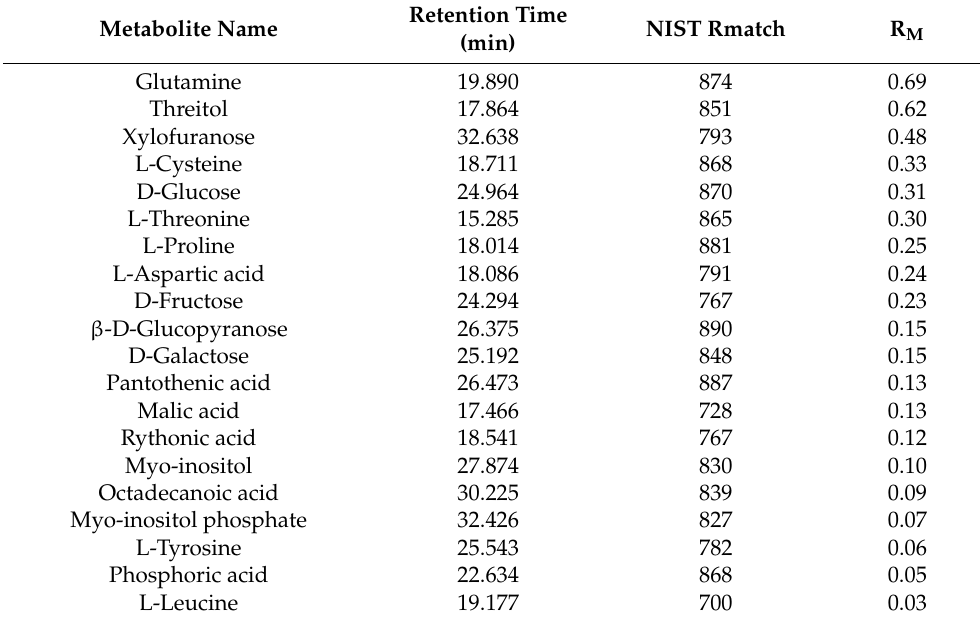
Table 1. Altered metabolites found in HepG2 cells exposed to 5 µ g/mL of AgNPs for 72 h by the GC-MS-based untargeted metabolomics approach (95% confidence